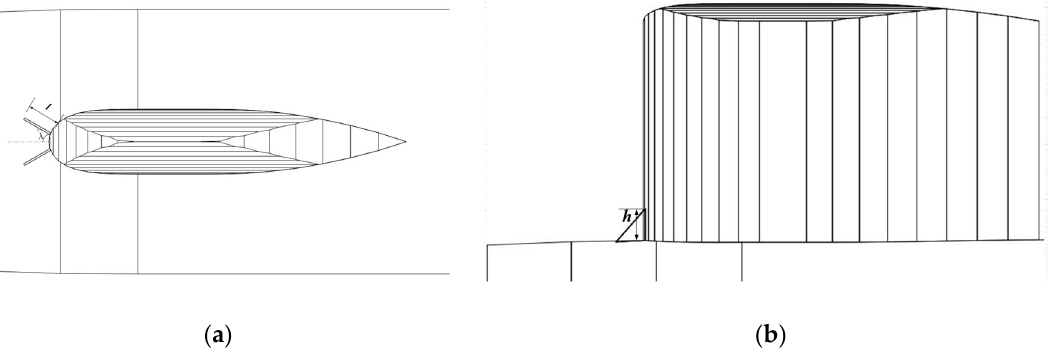
Figure 6. The sketch of the mechanical VGs on the model. ( a ) Top view; ( b ) side view.